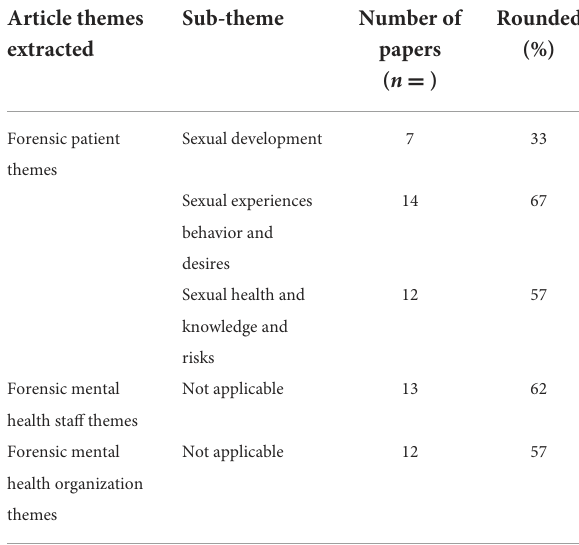
TABLE 4 Themes identified in the data